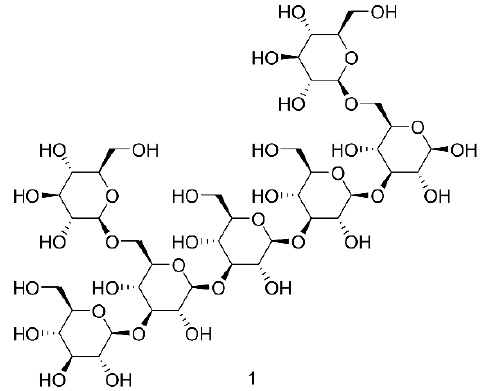
Figure 2. β -(1-3)-D-glucans with β -(1-6) single glucose residue side chains [35]. Additionally, this type of macromolecule is also found inside the body of Blattidae.